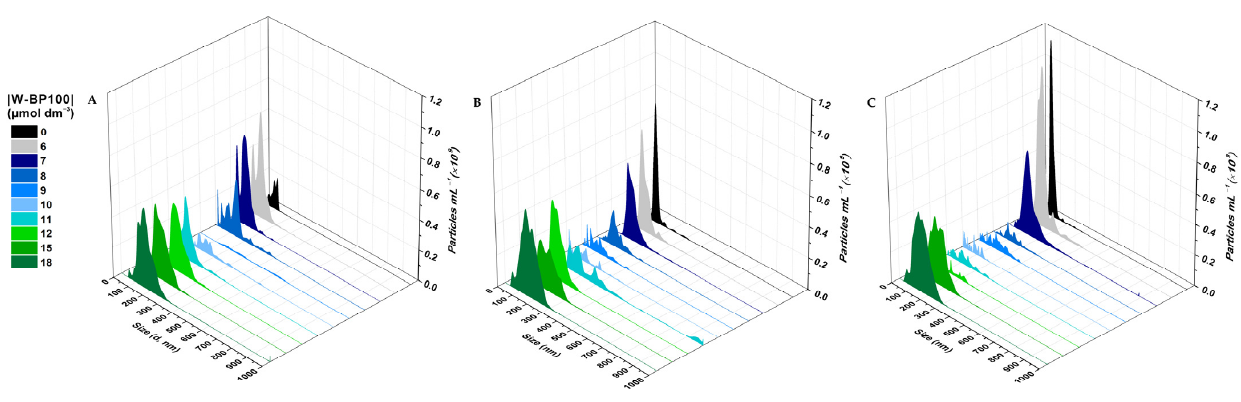
Figure 4. Size distribution of the POPC:POPG (1:1) LUVs in the presence of W-BP100 obtained from NTA measurements. Representative graphs of particle concentration as a function of size of 100 µmol dm − 3 POPC:POPG (1:1) LUVs at increasing W-BP100 concentrations, 25.0 ± 0.1 °C. Size distribution was measured at ( A ) day 0 (10 min upon peptide incubation), ( B ) day 1, and ( C ) day 7 upon peptide incubation. Data represent the mean of a maximum of 10 image fields.